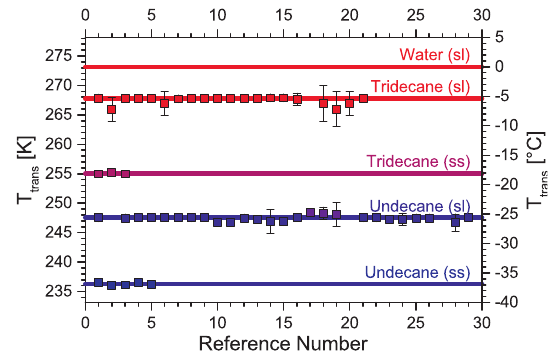
Figure A1. Literature values for the phase transitions of water, tridecane and undecane used for the temperature calibration. Sym- bols indicate individual literature values, and the lines represent their median used for the calibration. For data see Table A1.